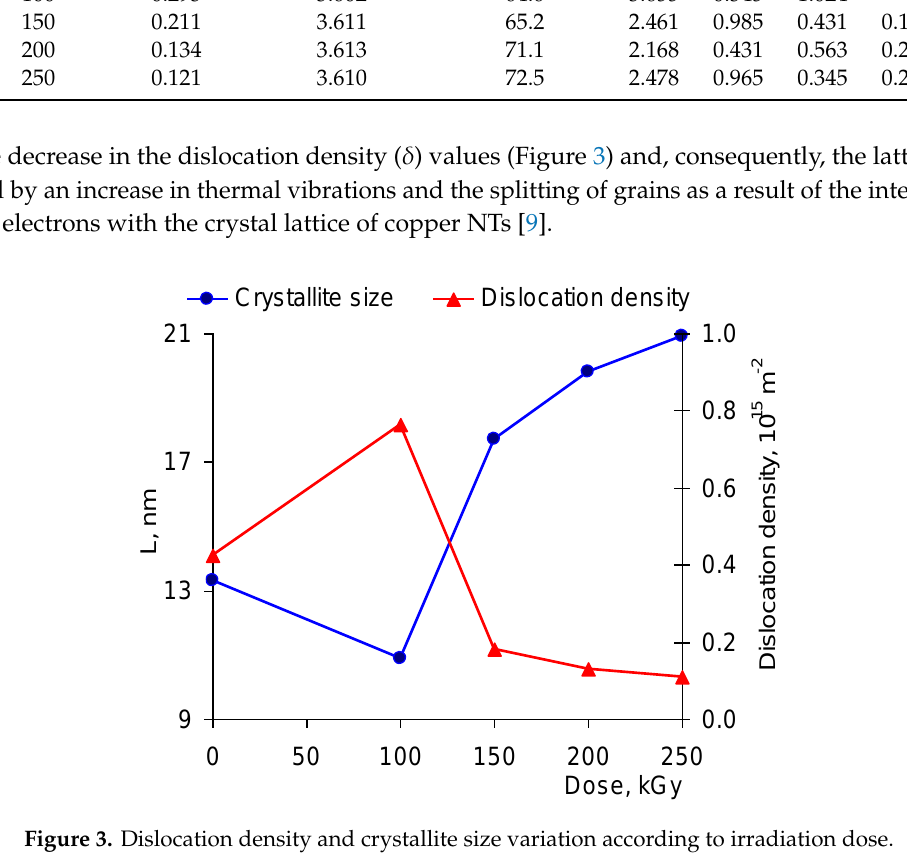
Figure 3. Dislocation density and crystallite size variation according to irradiation dose.